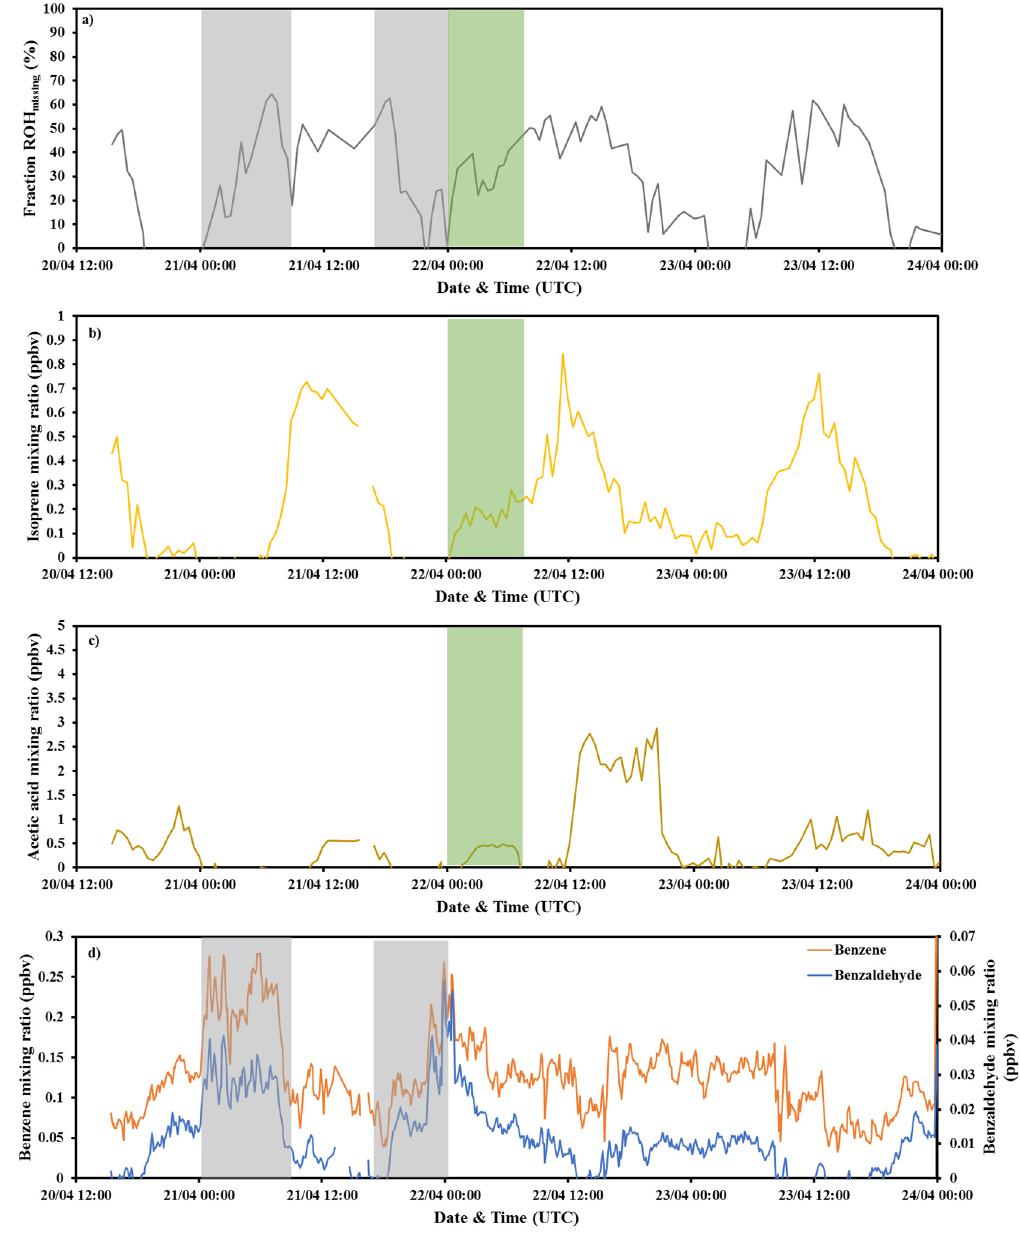
Figure 8. ( a ) Variability of relative missing OH reactivity (ROH missing / mROH chamber ) with ( b ) Isoprene (rapeseed), ( c ) Acetic acid (rapeseed) and ( d ) Benzene (orange) and Benzaldehyde (blue) in ambient air. Green areas indicate missing OH reactivity mainly due to biogenic emissions and grey areas indicate missing OH mainly linked to anthropogenic emissions.